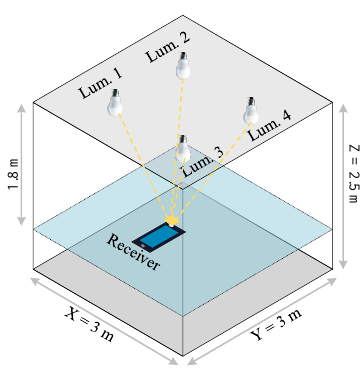
Figure 11. 3-D view of the room configuration with four luminaires and a QADA receiver.